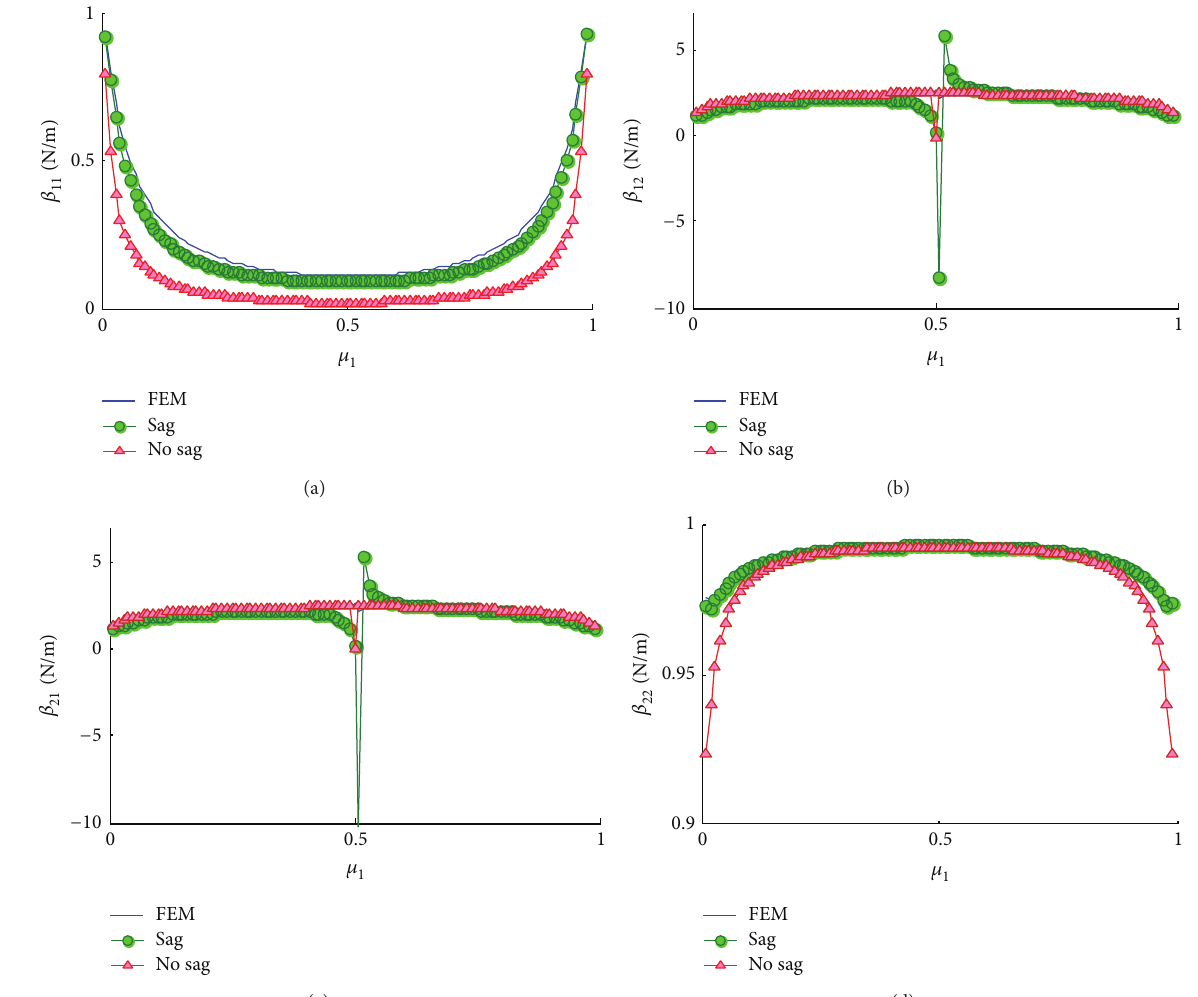
Figure 6: Comparison between the coefficient of the first-order dynamic stiffness obtained using the three presented methods ( 𝜔 𝑠 1 = 2.765 ).